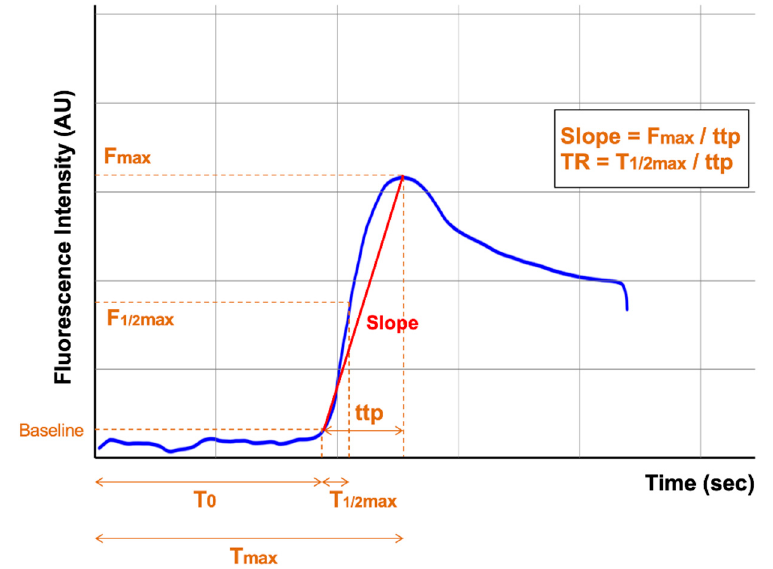
Figure 2. Fluorescence-time curve and quantitative parameters of ICF-FA. AU: arbitrary unit, F max : maximum fluorescence intensity, F 1/2max : half maximum fluorescence intensity, T 0 : time from ICG injection to first fluorescence signal, T max : time from ICG injection to maximum fluorescence signal, T 1/2max : time from first to half maximum fluorescence signal, ttp (time-to-peak): T max − T 0 , Slope: F max /ttp, TR (the time ratio): T 1/2max /ttp.